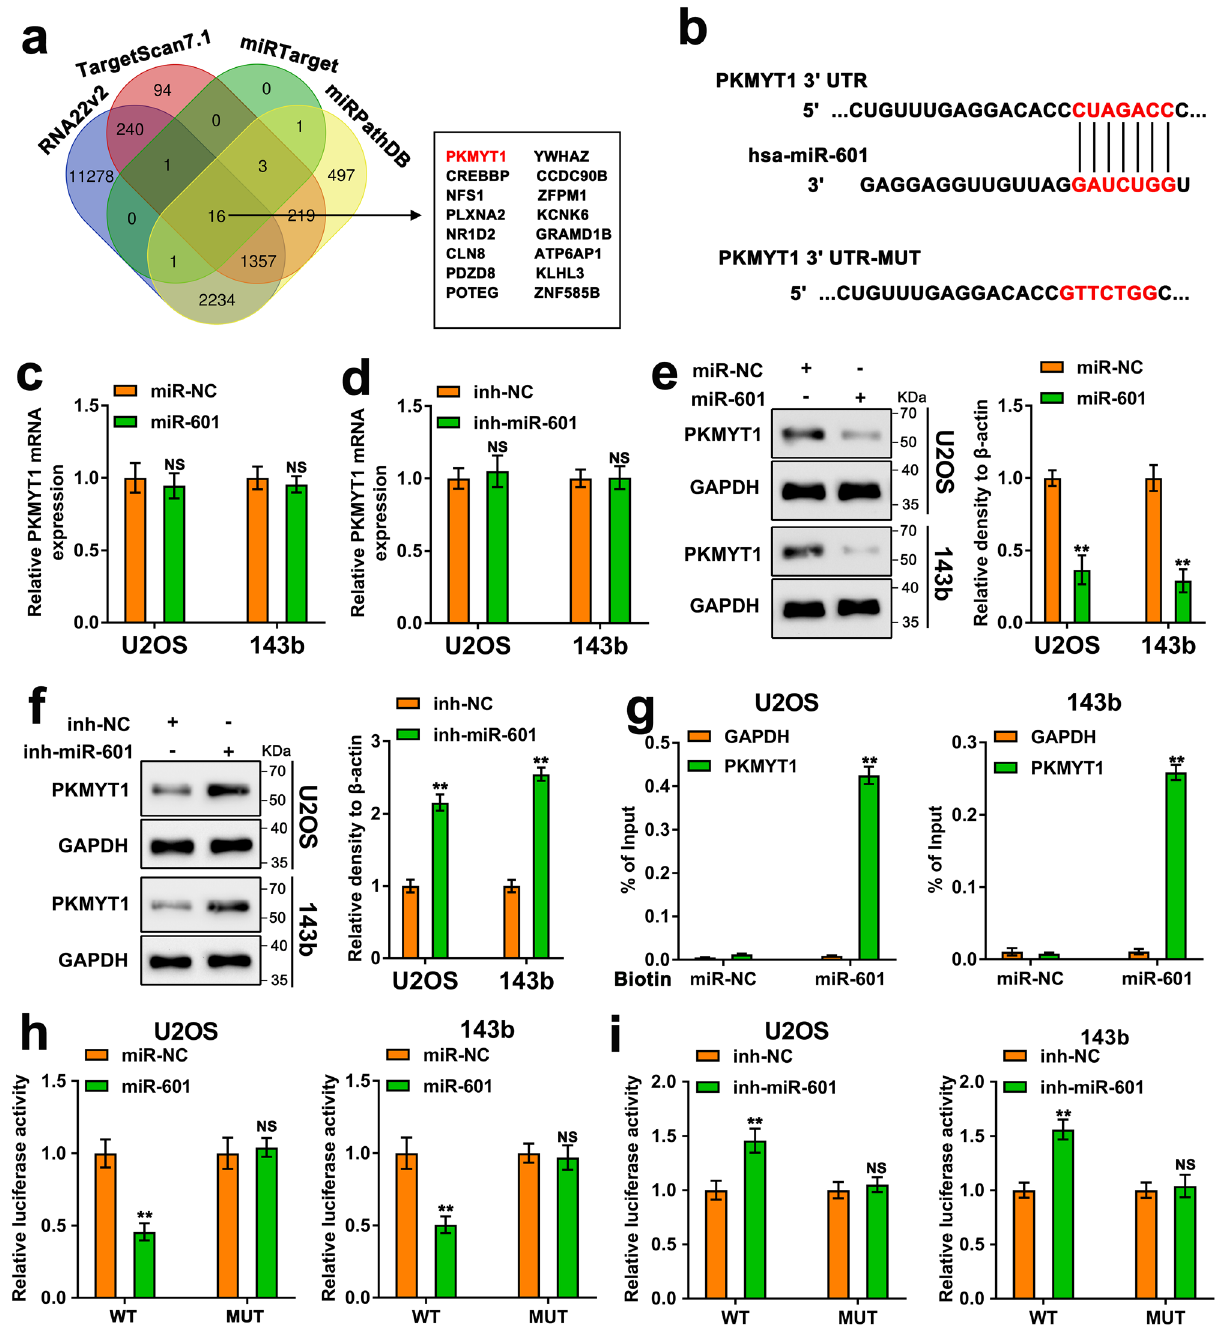
Figure 3. miR-601 mediates the downregulation of PKMYT1. ( a ) Venn diagram displayed the targets of miR-601 predicted by the databases of RNA22v2, TargetScam 7.1, miRTarget and miRPathDB. ( b ) Schematic diagram displayed the putative binding sequence of 3’-UTR-PKMYT1- mRNA and miR-601. The mutated sites of the 3’-UTR-PKMYT1- mRNA was showed. ( c, d ) The expression of PKMYT1 mRNA in miR-601 upregulated or downregulated U2OS and 143b cells was measured via RT-qPCR experiment. ( e, f ) The protein of PKMYT1 in miR-601 upregulated or downregulated U2OS and 143b cells was measured via Western blot experiment. The original blots/gels are presented in Supplementary Dataset File. ( g ) The enrichment of PKMYT1 on biotinylated miR-NC and miR-601 probe was evaluated by biotin-based pulldown assay. The GAPDH mRNA served as control. ( h, i ) Luciferase activity of U2OS and 143b cells was accessed through luciferase reporter